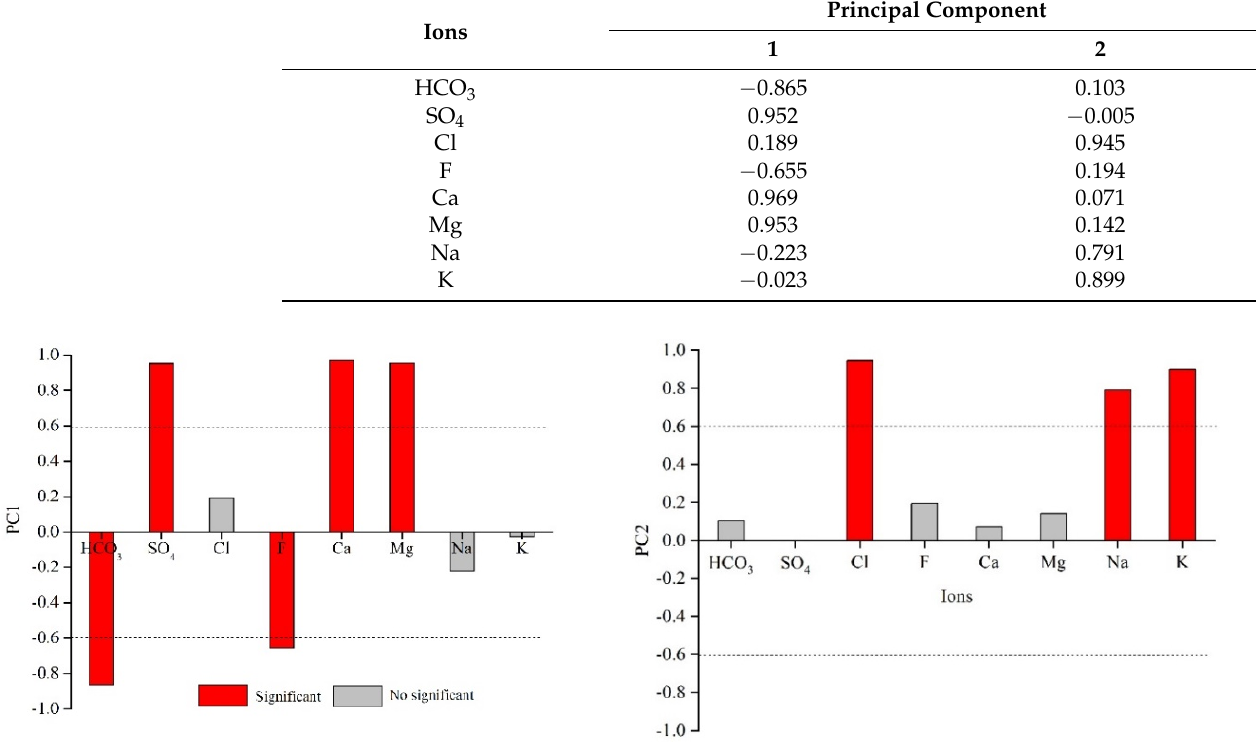
Figure 4. Extraction of characteristic ions from principal components.